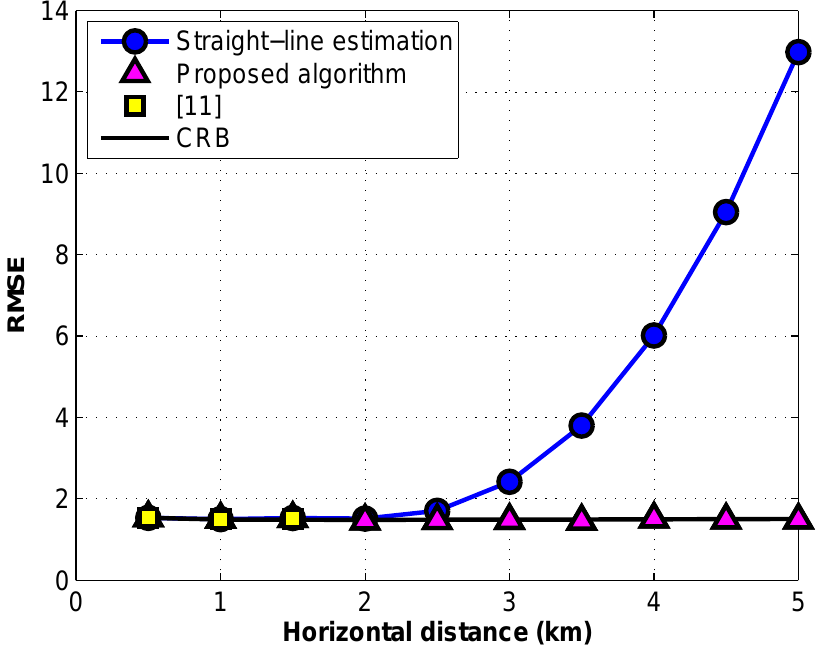
Figure 10. Performance of the proposed algorithm for deep